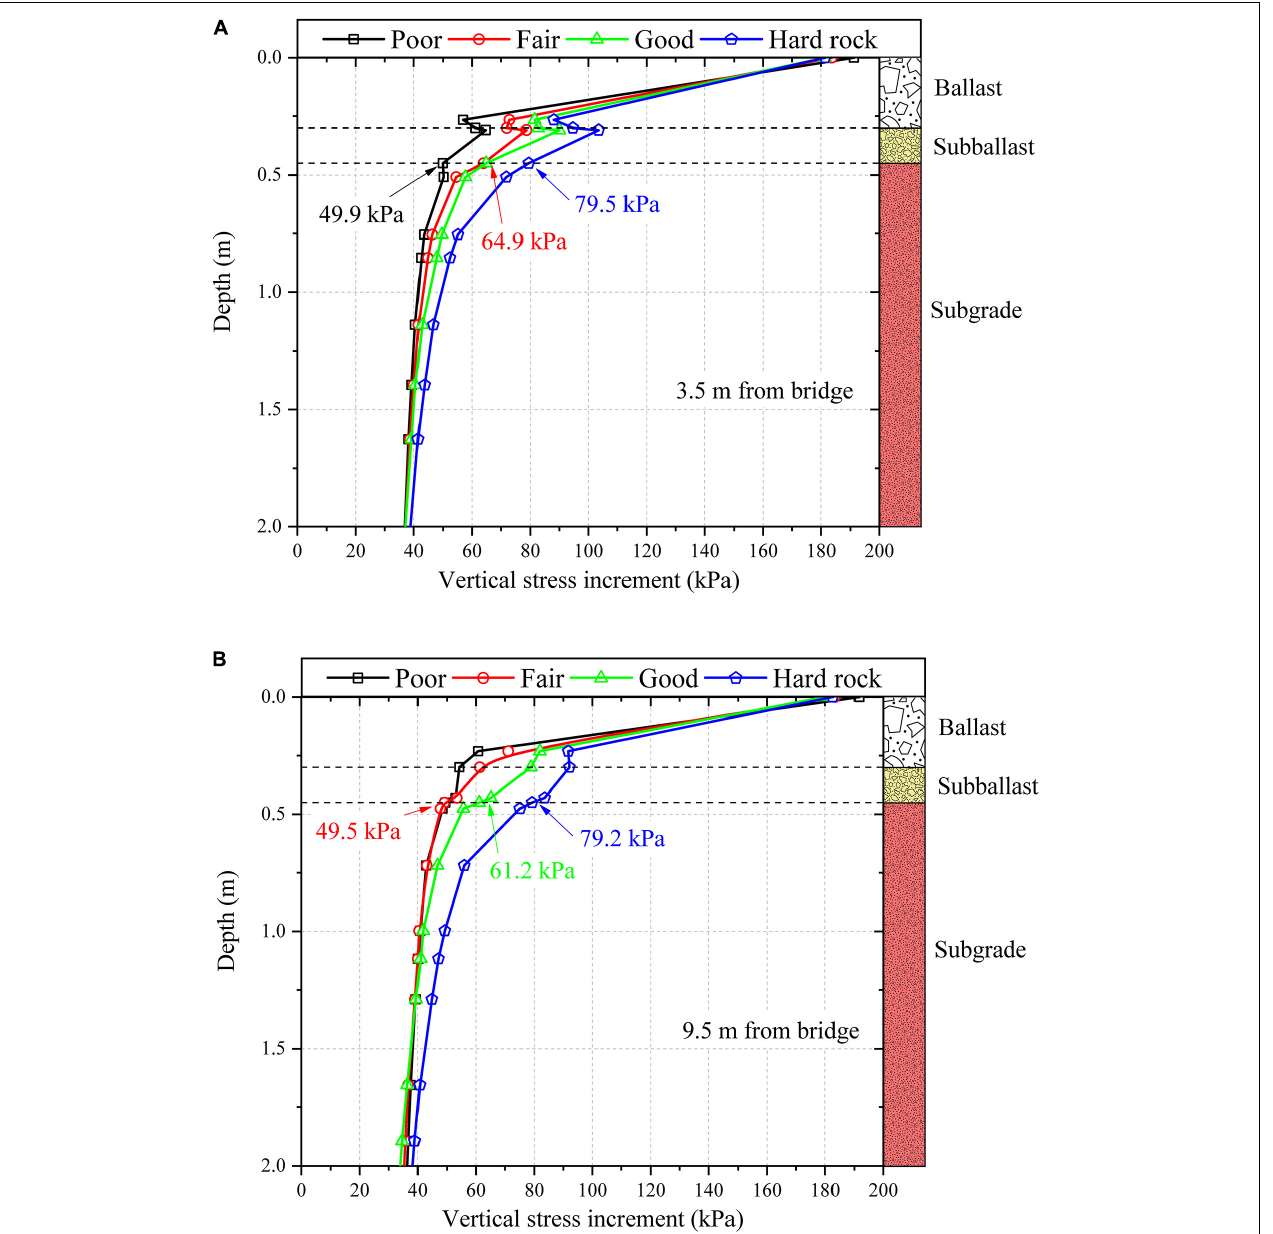
FIGURE 6 | Variation of vertical stress increment with depth for four different subgrade types at (A) : 3.5 m from the bridge; (B) 9.5 m from the bridge.